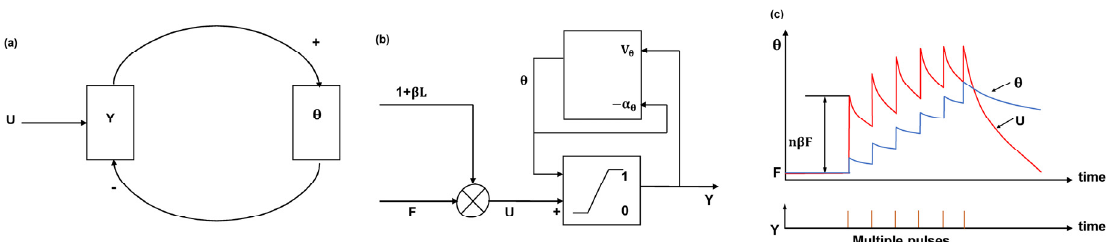
Figure 2. Schematic of the pulse-coupled neural network. ( a ) Connection between the internal activity 𝑼 (cid:3036)(cid:3037) , timing pulse sequence 𝒀 , and dynamic threshold 𝜽 (cid:3036)(cid:3037) . ( b ) Schematic of the PCNN. ( c ) Activity of the internal activity 𝑼 (cid:3036)(cid:3037) and dynamic threshold 𝜽 (cid:3036)(cid:3037) under stimulation of multipule pulses.